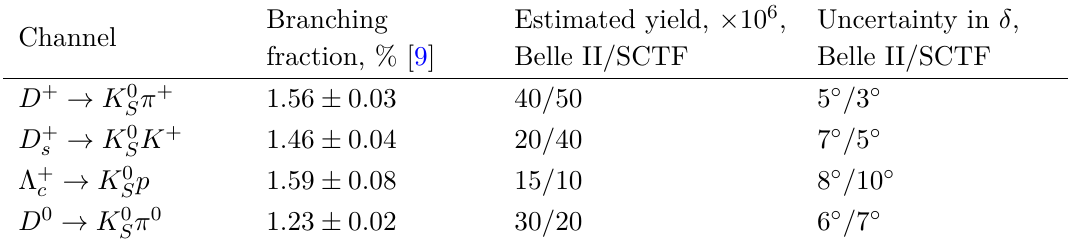
Table 1 . Branching fractions and production yields for considered channels. In the brackets estimated statistical uncertainty in δ measurement is specified.